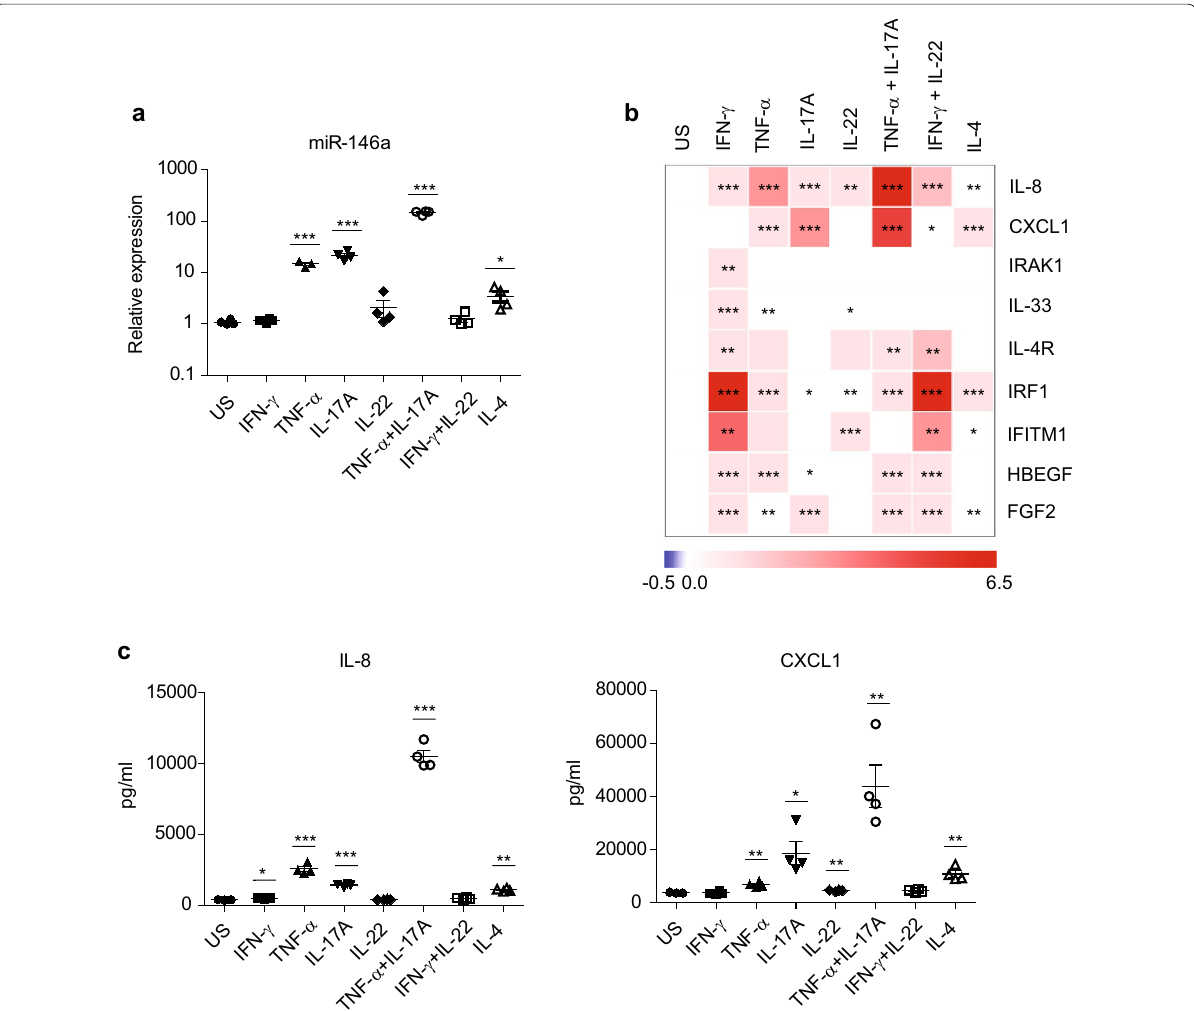
Fig. 3 Pro-inflammatory cytokines induce the expression of miR-146a in HBECs. Cultured HBECs were stimulated with shown cytokines for 48 h or left unstimulated (US). a Relative expression of miR-146a expression was measured by RT-qPCR and is shown in comparison with US cells. b Heatmap of relative mRNA expression levels of indicated genes measured by RT-qPCR. Log2 values of fold changes were mean-centered for each gene separately. c IL-8 and CXCL1 protein levels from the supernatants of cytokine stimulated HBECs measured by ELISA. a , c Data represent mean SEM. a–c Unpaired t-test, *P < 0.05, **P < 0.01, ***P < ±